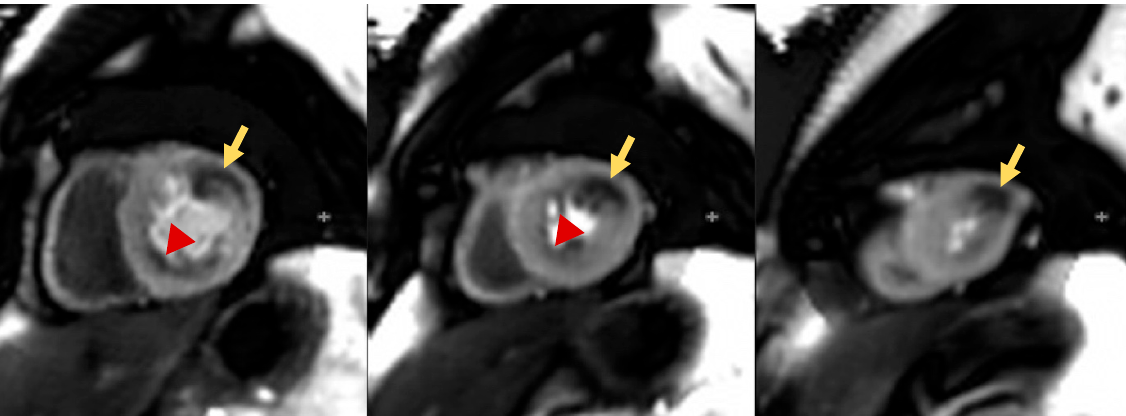
Figure 3. Pediatric patients affected by KD with multiple aneurysms. The stress perfusion sequences show significant myocardial perfusion defects in the basal to mid anterolateral and apical lateral walls (likely circumflex territory, yellow arrows). Separately, there is also a mild subendocardial perfusion defect in the basal to mid inferior wall and inferoseptum (likely right coronary artery territory, red arrow heads).